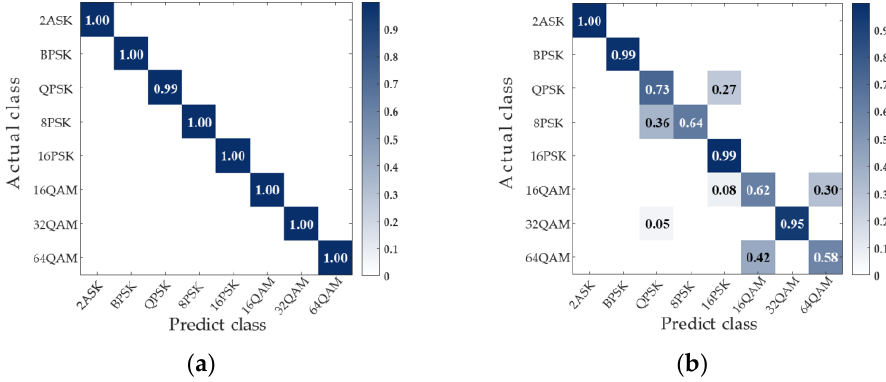
Figure 5. Confusion matrices of CNN-MK-MDD on ( a ) source and ( b ) target datasets.